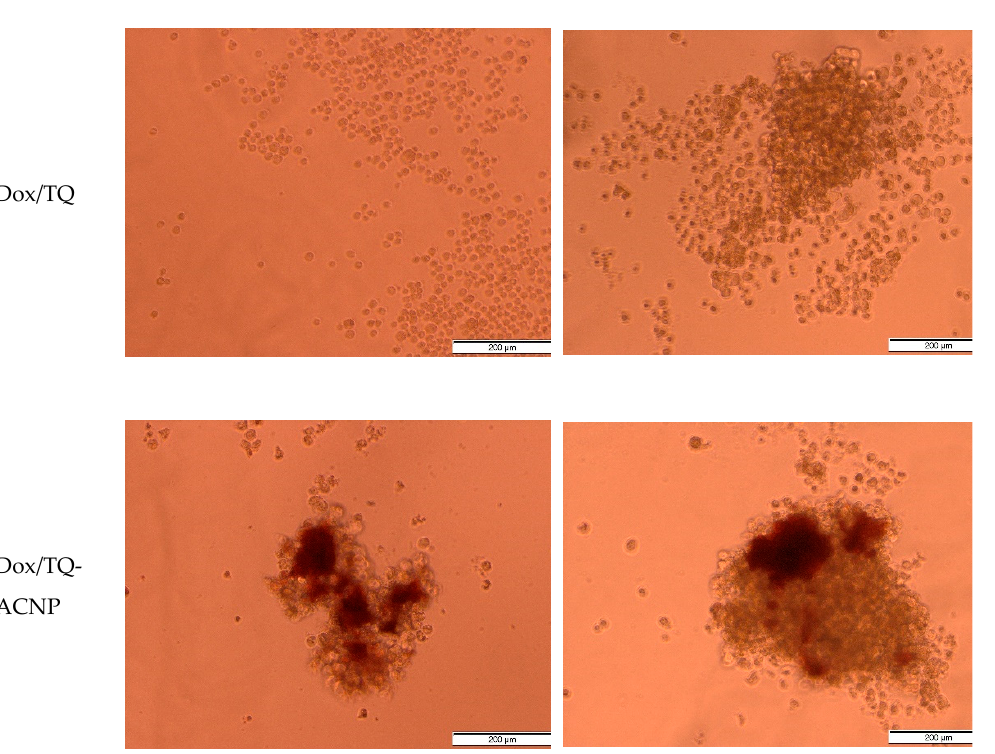
Figure 9. Photomicrographs of light microscopy showing the morphology of the mammosphere at days 0 and 10 after treatments.